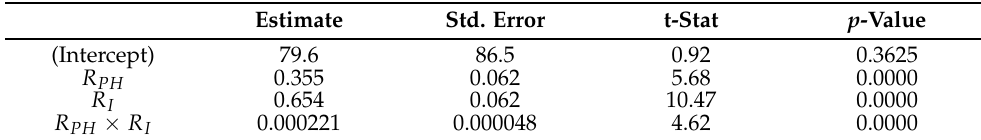
Table 5. Regression Model for the Mean HP[kW] for the 243 maximum values. Estimate Std. Error